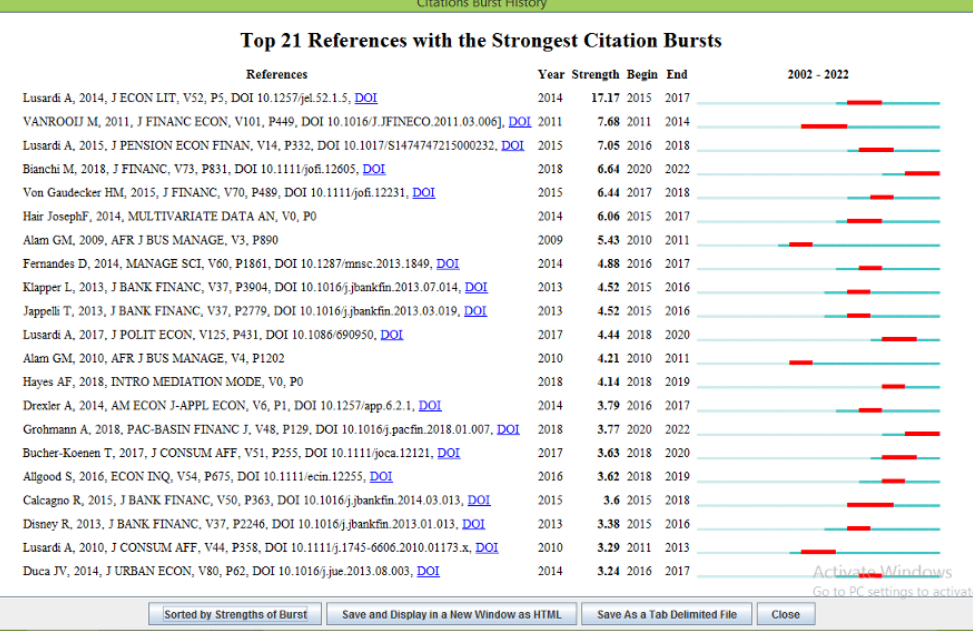
Figure 7. Citation bursts history during the period 2002–2022 prepared using CiteSpace